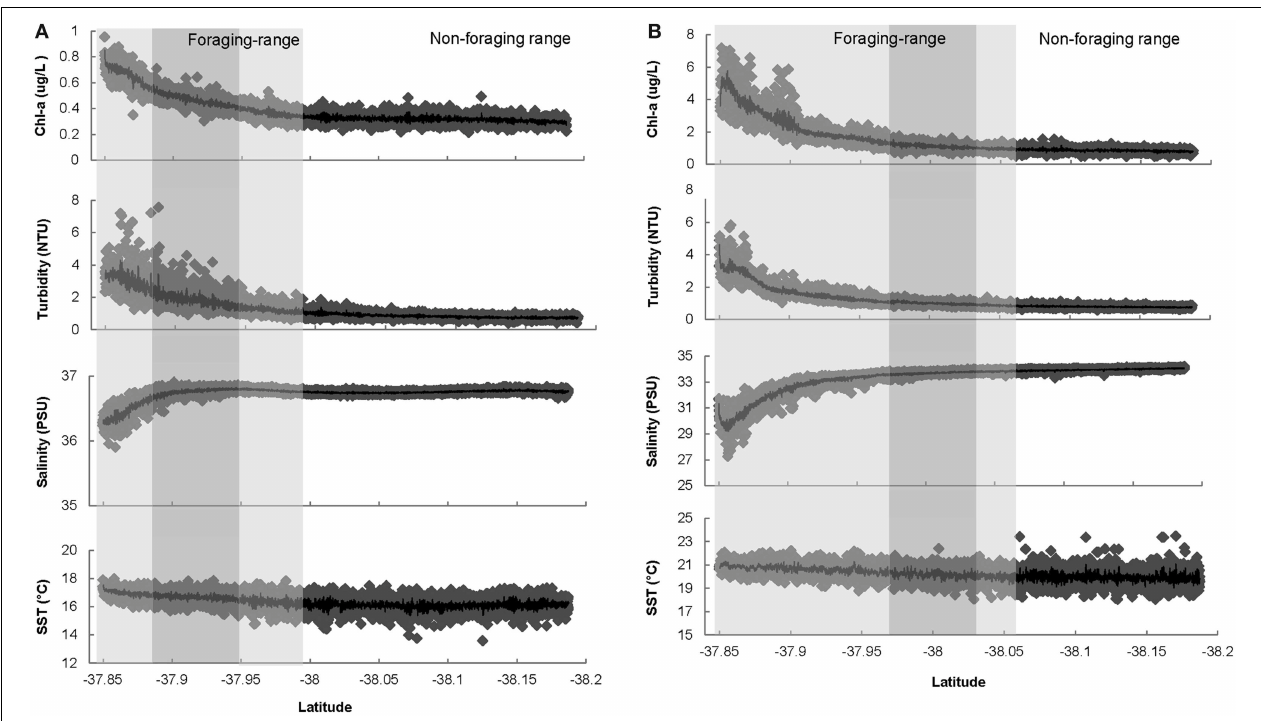
penguins. (B) Environmental characteristics measured along the Ship of Opportunity route during the 2011 penguin breeding season (Nov–Jan), commencing at Station Pier, in close proximity to the Yarra River mouth and ending at a latitudinal coordinate of − 38 . 18 ◦ S approximately 30 km (straight line distance) from the St Kilda penguin colony. Shaded areas indicate the mean 2011 foraging range of penguins and comprise the home-range (95% KUD) shaded in light gray, and the core-range (50% KUD) shaded in dark gray. The non-shaded area represents the mean 2008 non-foraging range of